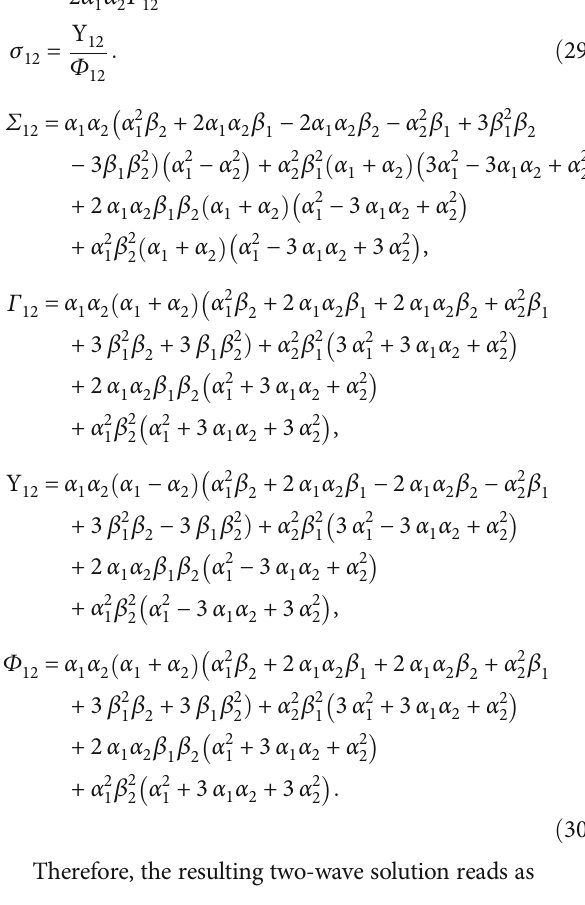
x = − 10 , x = 0 , and x = 10